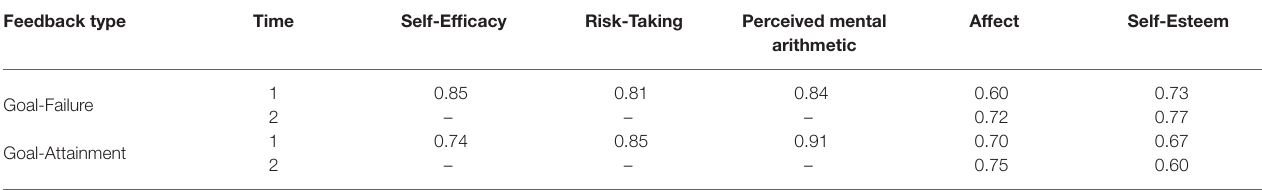
TABLE 4 | Cronbach’s α for goal-failure conditions and measurement